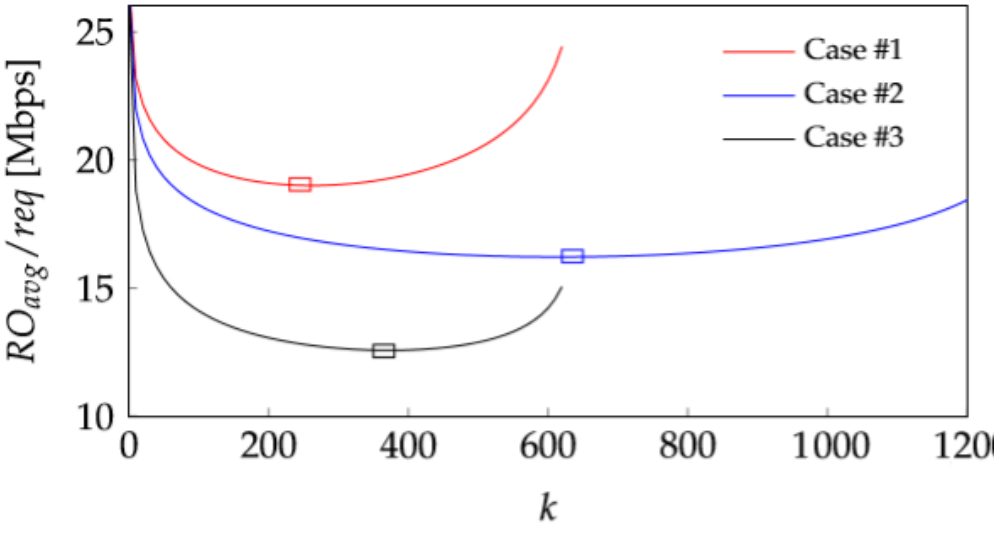
Figure 4. RO avg / req with respect to k , the number of items stored in the access-metro edge node (AMEN) caches for each of the three case studies.